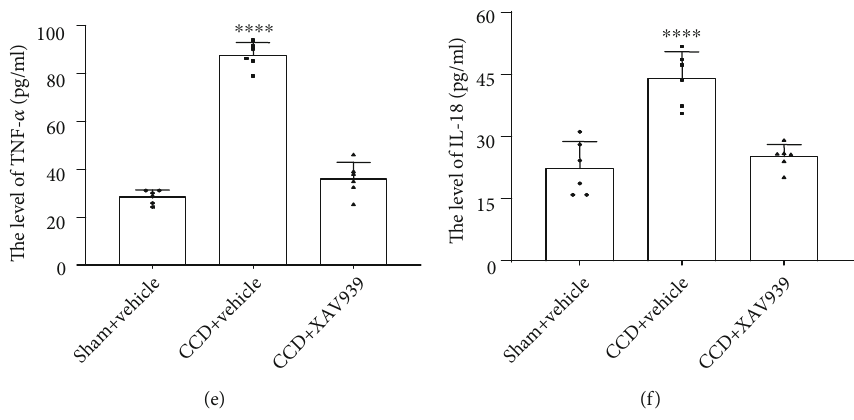
Figure 3: Intraperitoneal injection of XAV939 attenuated mechanical allodynia and decreased TNF- α and IL-18 levels in serum after CCD. (a) Schematic time course for acclimation, CCD surgery, intraperitoneal injection of XAV939, behavioral testing, and sacri fi ce. (b) MWT measured on 0, 1, 3, 5, and 7 days after CCD treatment ( n = 9 ). Two-way ANOVA. Western blot showing active β -catenin expression in (c) DRG and (d) SCDH ( n = 6 ). ELISA showing the expression of (e) TNF- α and (f) IL-18 in the serum of rats after intraperitoneal injection of XAV939 ( n = 6 ). Serum was collected at di ff erent time points after CCD. One-way ANOVA. Bars represent group means ± SD . #### P < 0 : 0001 , CCD+vehicle versus sham; ∗∗∗∗ P < 0 : 0001 , CCD+XAV939 versus